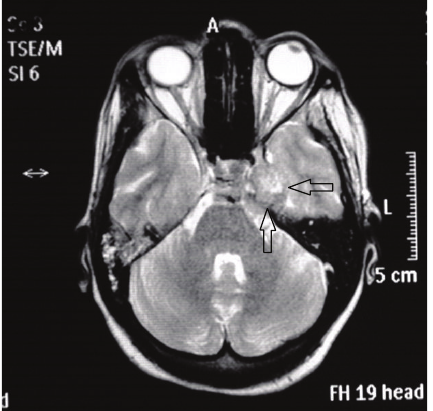
Figure 4: MRI postcontrast showing altered signal intensity of the clivus, axial section that appears heterogeneously